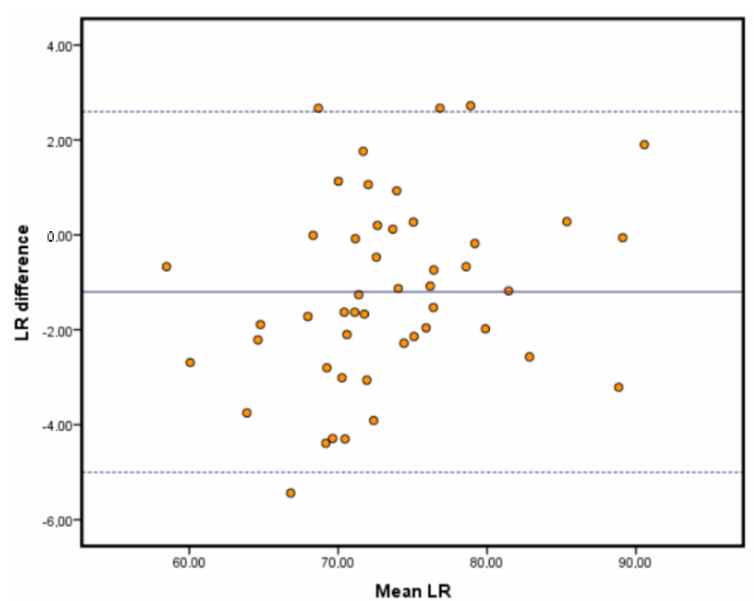
Figure A6. Bland-Altman plot left